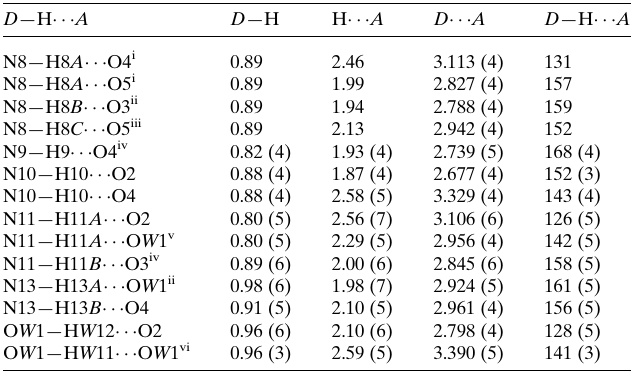
Table 1 Hydrogen-bond geometry (A˚ , (cid:6) ).